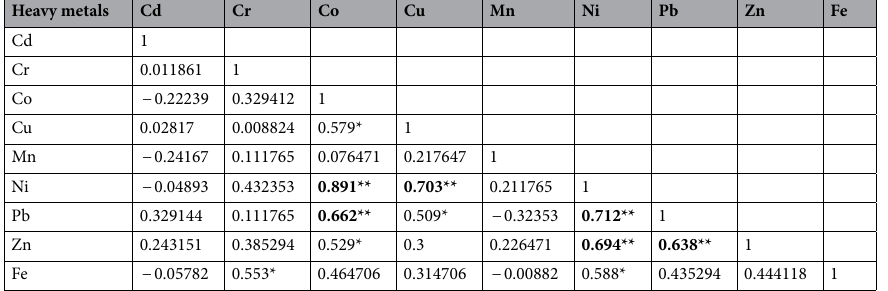
Table 5. Spearman’s correlation analysis of TEs in soil samples from saffron farms. *Correlation is considered significant at the 0.05 level (2-tailed) for two elements. **Correlation is considered significant at the 0.01 level (2-tailed) for two elements. Significant values are in